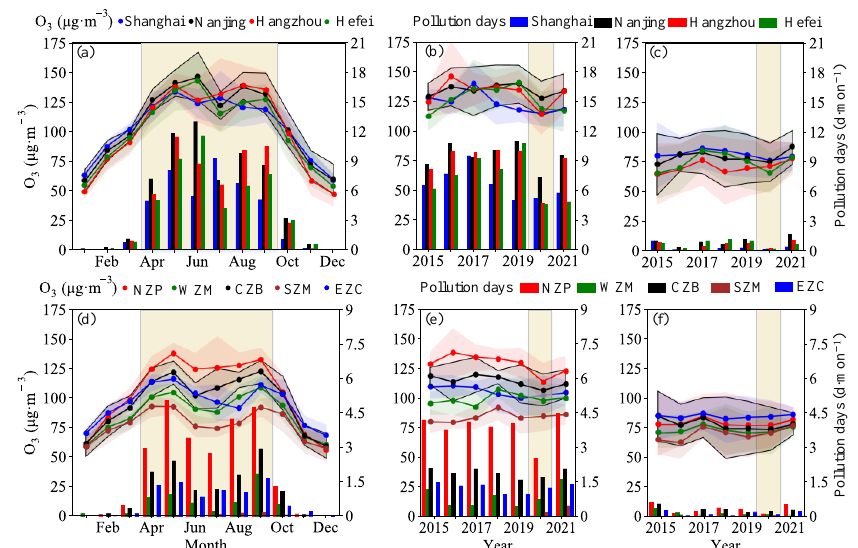
Figure 3. Megacities’ and regional monthly variation ( a , d ) from 2015 to 2021, and yearly variation during ( b , e ) April – September and ( c , f ) October – March of mean O 3 concentration and pollution days per month. One standard deviation of O 3 concentration is shown as a shadow of the corresponding color. Regions of NZP, WZM, CZB, SZM and EZC were divided in Section 2.1 and Figure 1.